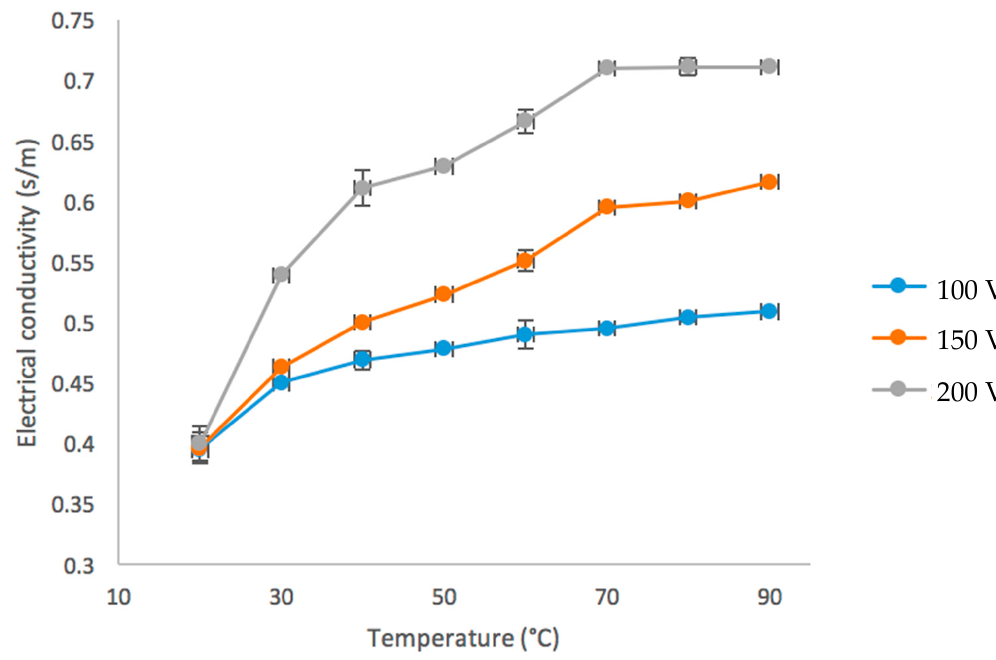
Figure 3. Changes in electrical conductivity given to temperature of aguamiel at different voltages.